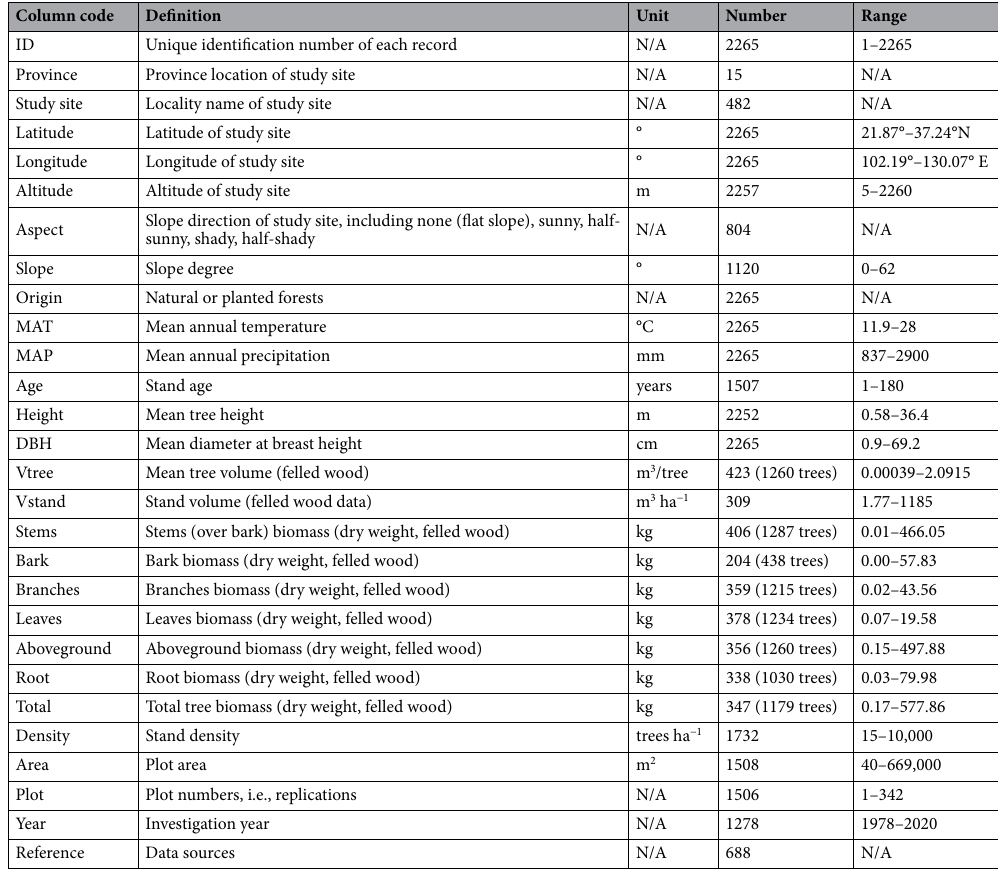
Table 1. Variable information in the data set.